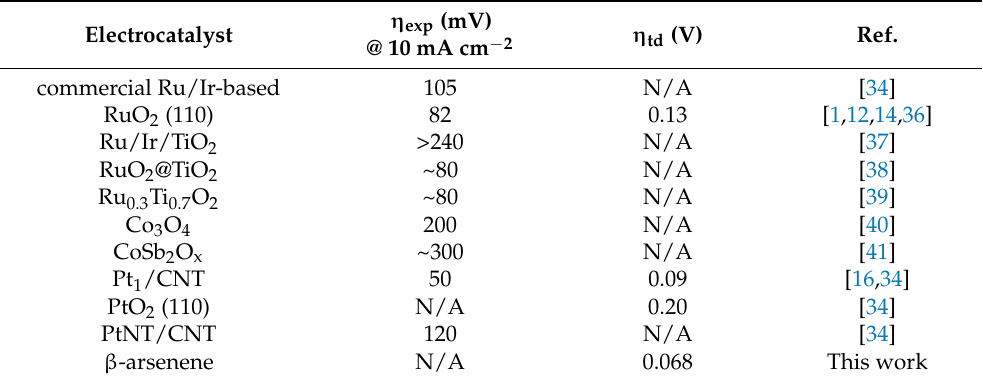
Table 3. Summary of the experimental ( η exp ) and thermodynamic overpotentials( η td ) of reported electrocatalysts for chlorine evolution a